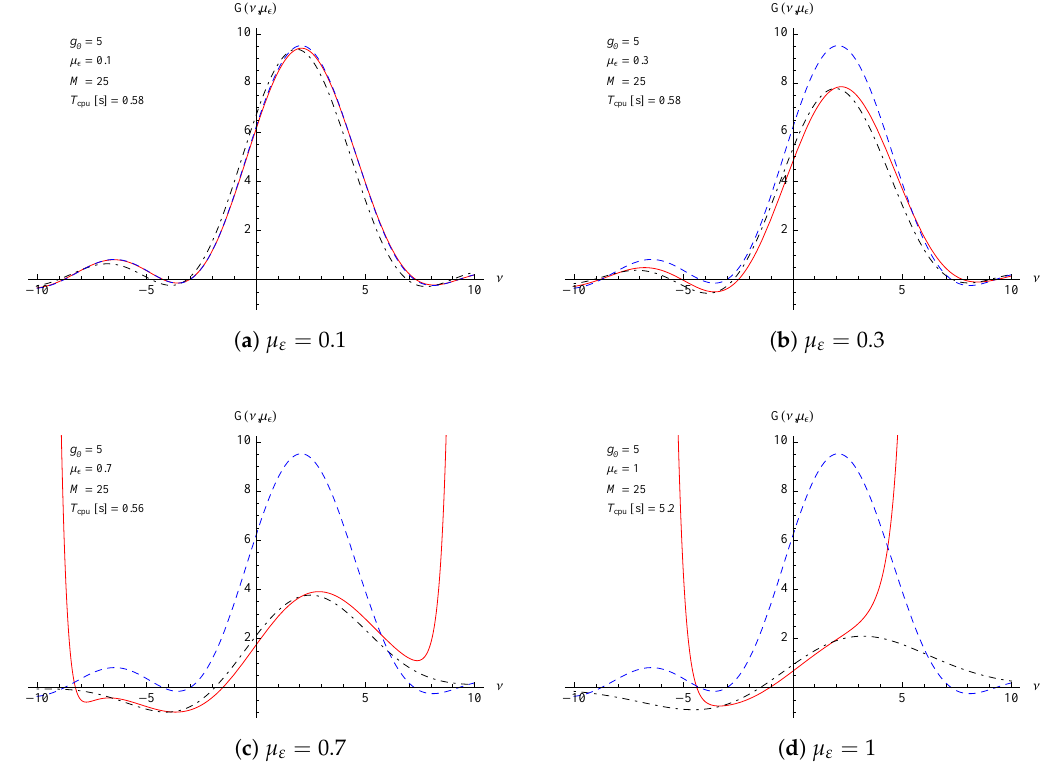
Figure 2. Comparison with analiytical expression (black dash-dotted line with different broadening effect ( µ ε )) and with the complete numerical integration (blue dashed line, which has no broadening effect) and g 0 = 5. The CPU time used refers an Intel I7 3 GHz